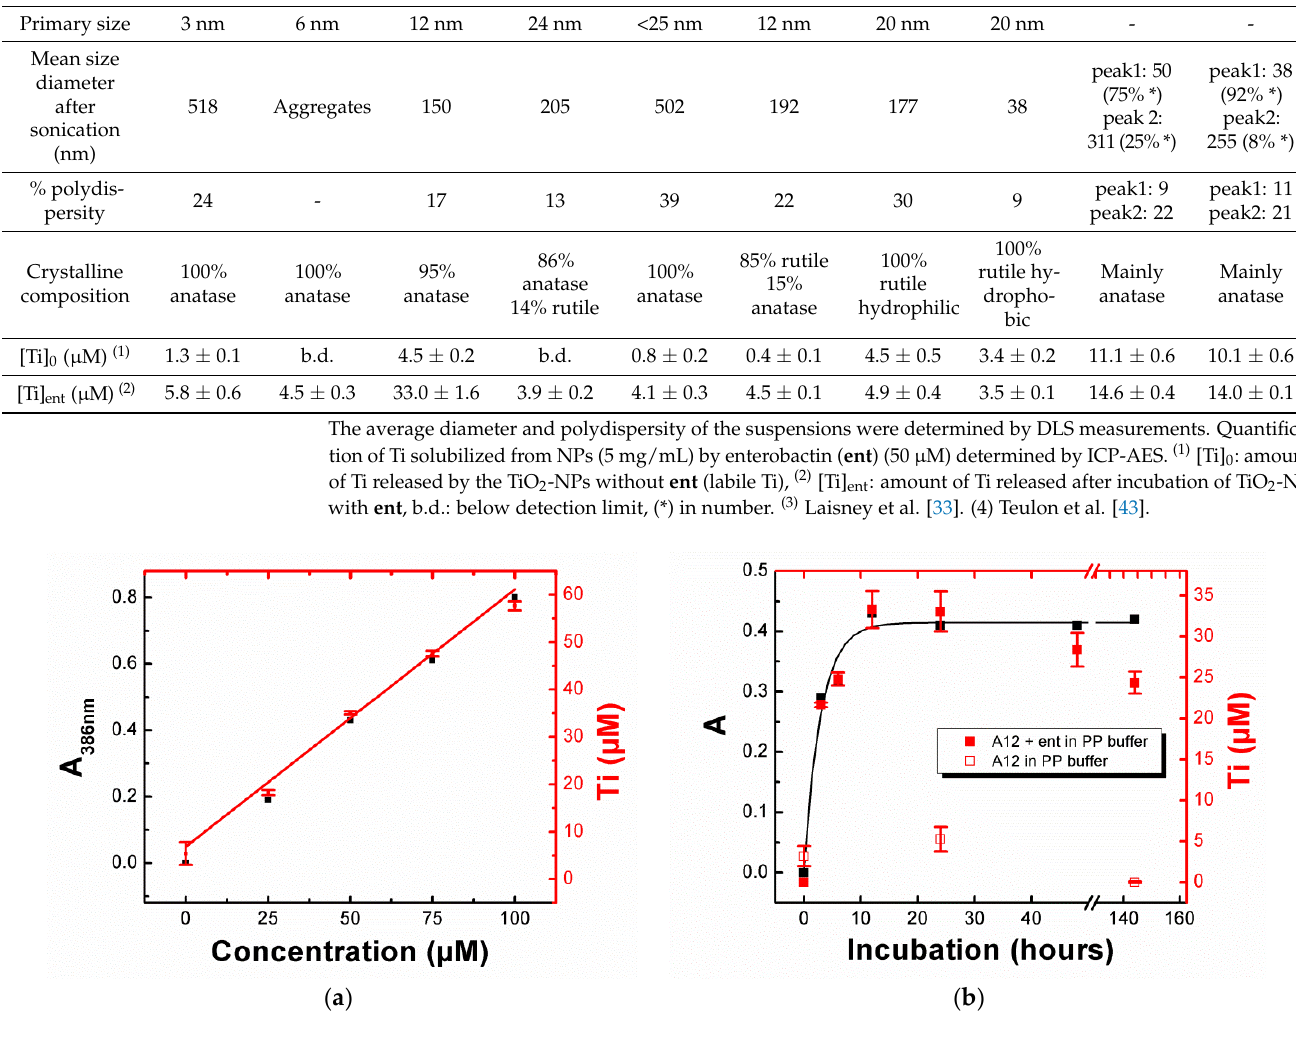
Figure 3. The influence of ent concentration and incubation time on the solubilization of TiO 2 -A12 NPs (5 mg/mL) in PP medium. UV – visible absorbance at 386 nm (black) and Ti quantified by ICP- AES (red) as a function of ( a ) ent concentration after 24 h incubation, and ( b ) incubation time with ent (50 μM). Error bars were determined by calculating the standard deviation of duplicate experi- ments. Red squares correspond to A12 incubation in the PP buffer in the presence (filled square) or absence of ent (open square).